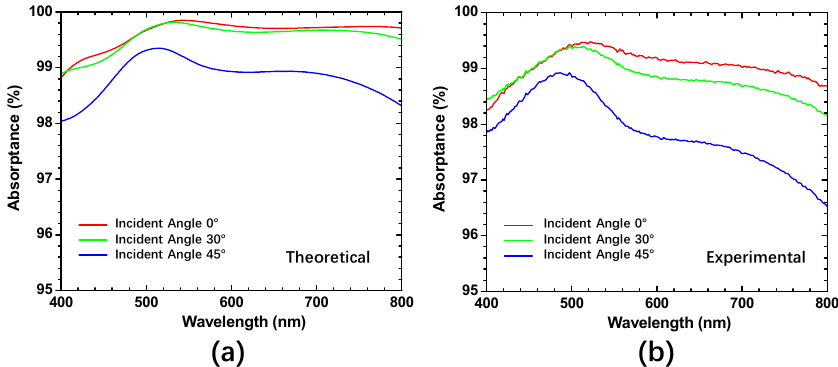
Figure 2. ( a ) The calculated absorption spectra of the designed absorber under di ff erent incident angle; ( b ) the measured absorption spectra of our fabricated absorber under different incident angles.